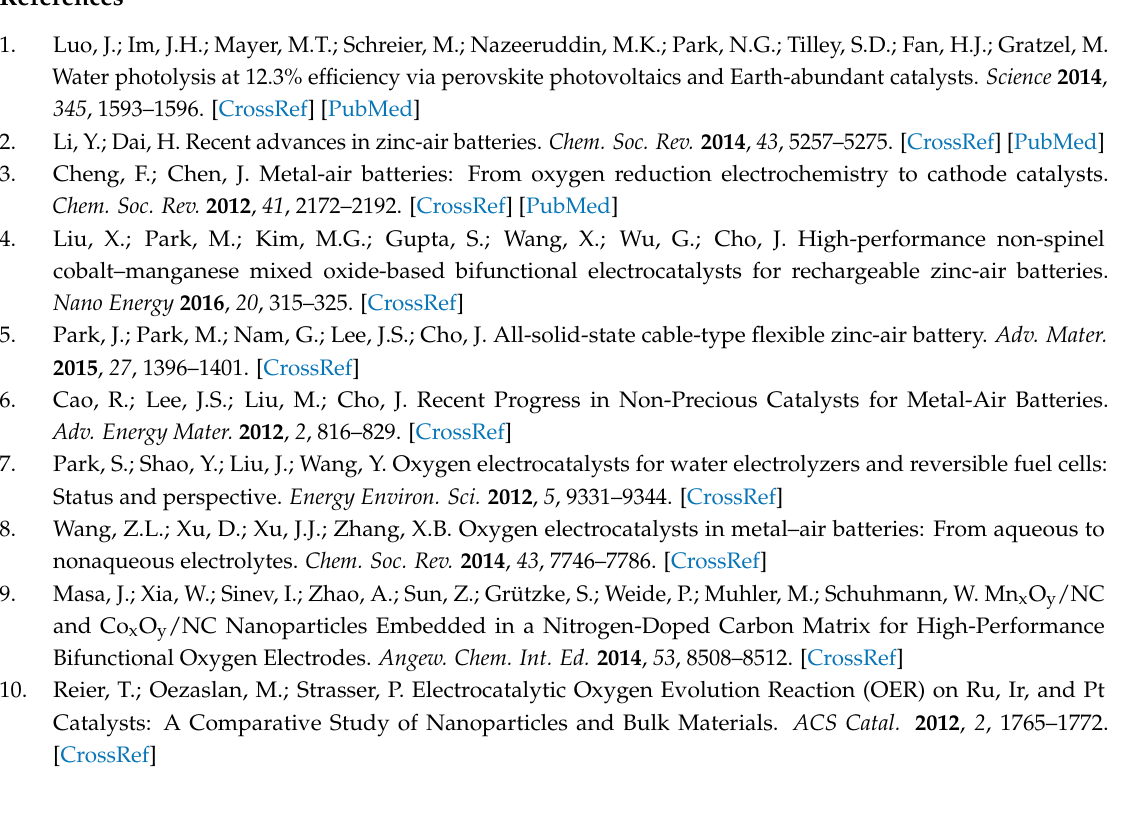
Table S1: Comparison of bifunctional oxygen electrode activity data for different catalysts; Table S2: Comparison of the performances of rechargeable Zn–air battery for different